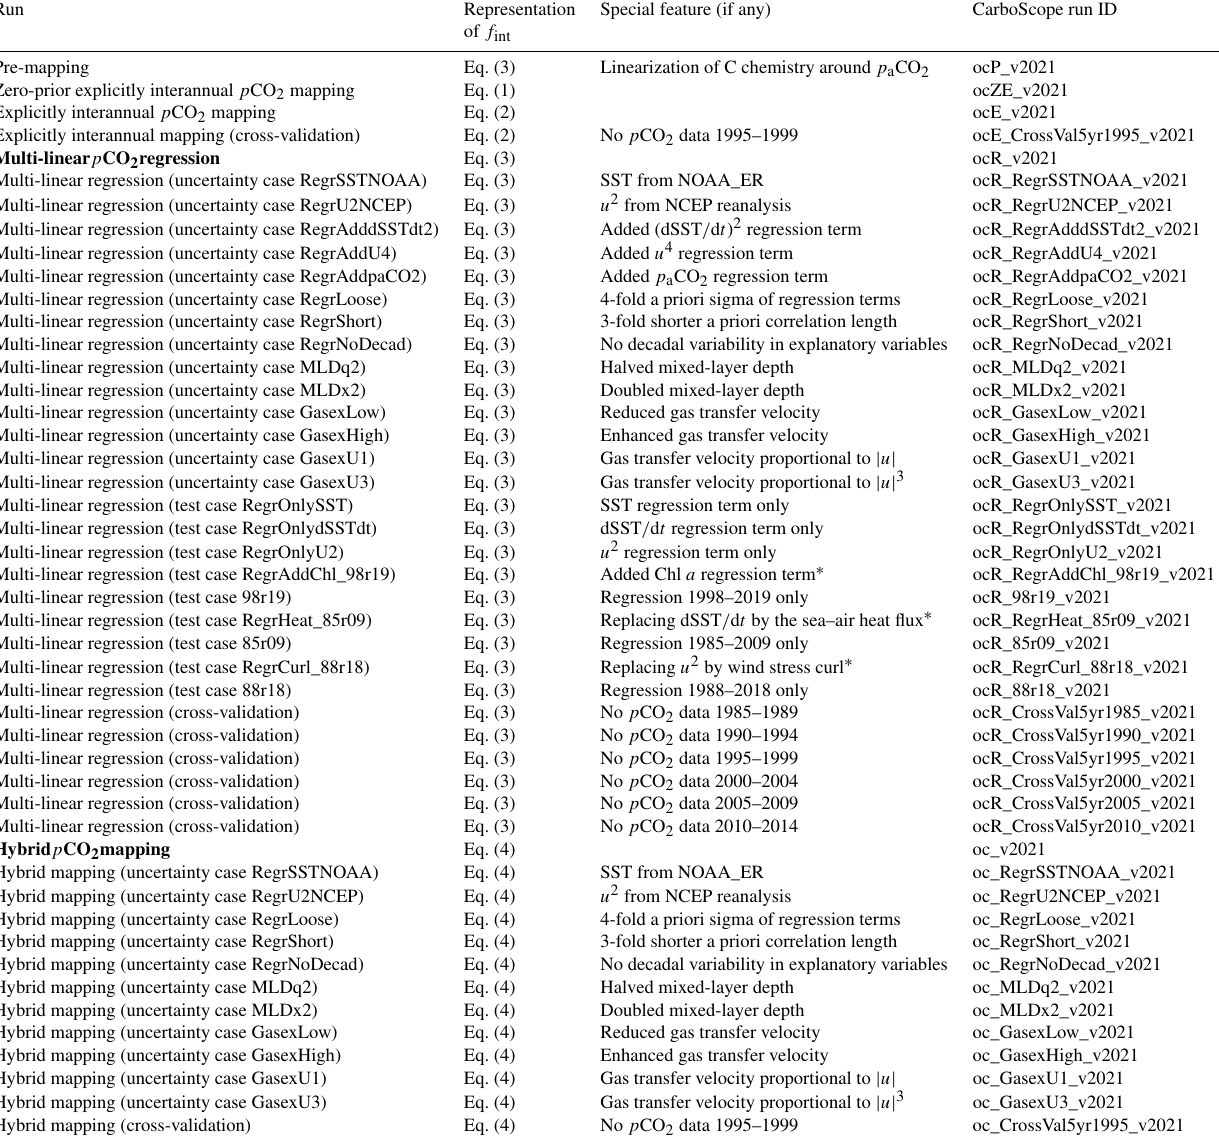
Table 2. Mapping runs used in this study. The main results are given in bold; the other runs are used to assess uncertainty (“uncertainty cases”; Sect. 2.2), to illustrate specific points of discussion (“test cases”; Sect. 2.2), or to assess predictive skill (“cross-validation”; Sect.